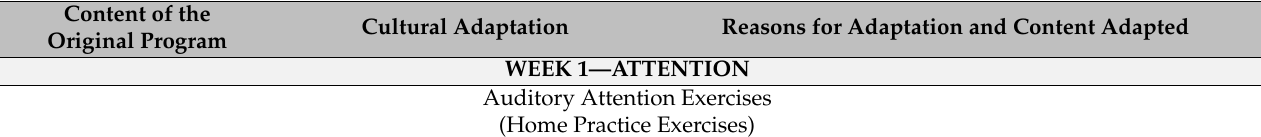
Table 2. Cultural adjustments made to the UCLA program during its adaptation to Portugal and the rationale behind such